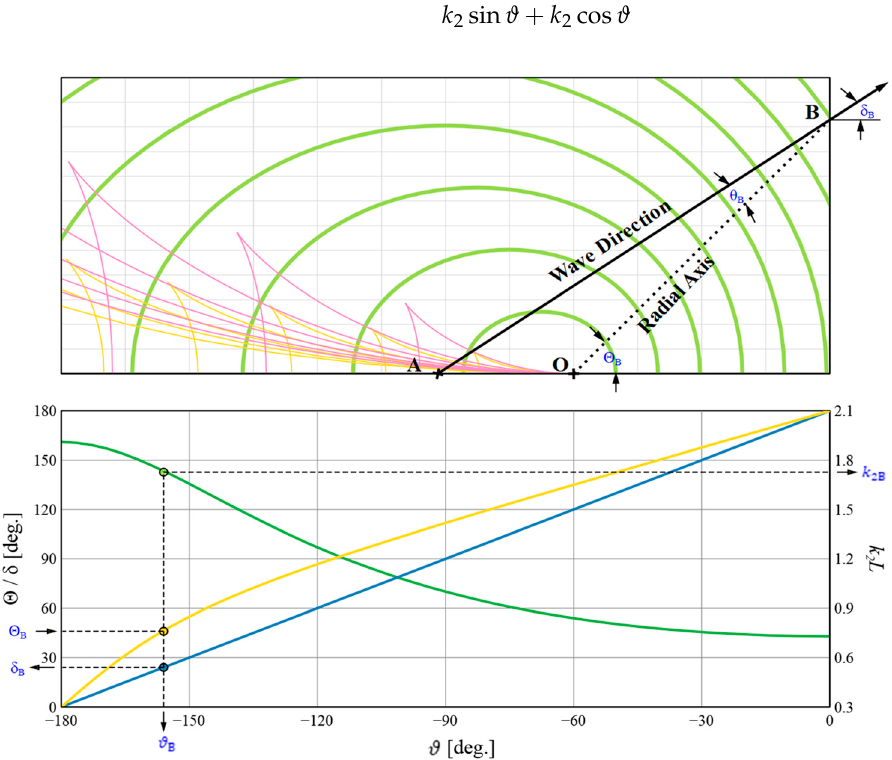
Figure 6. Relationship among the local scattered wave characteristics. ( Top ) Green line: b 2 -waves (circular waves), Pink line: a 1 -waves (divergent & transverse waves), Orange line: a 2 -waves (divergent & transverse waves); ( Bottom ) Green curve: k 2 vs. ϑ , Blue curve: δ vs. ϑ , Orange curve: Θ vs. ϑ .